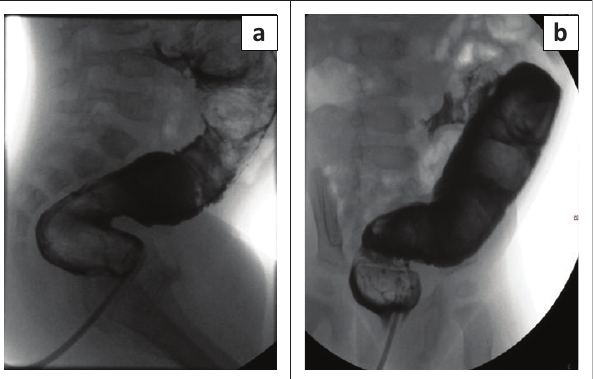
FIGURE 3: Lateral (a) and frontal (b) views in a patient with Hirschsprung disease. The lateral view demonstrates a reversed recto-sigmoid